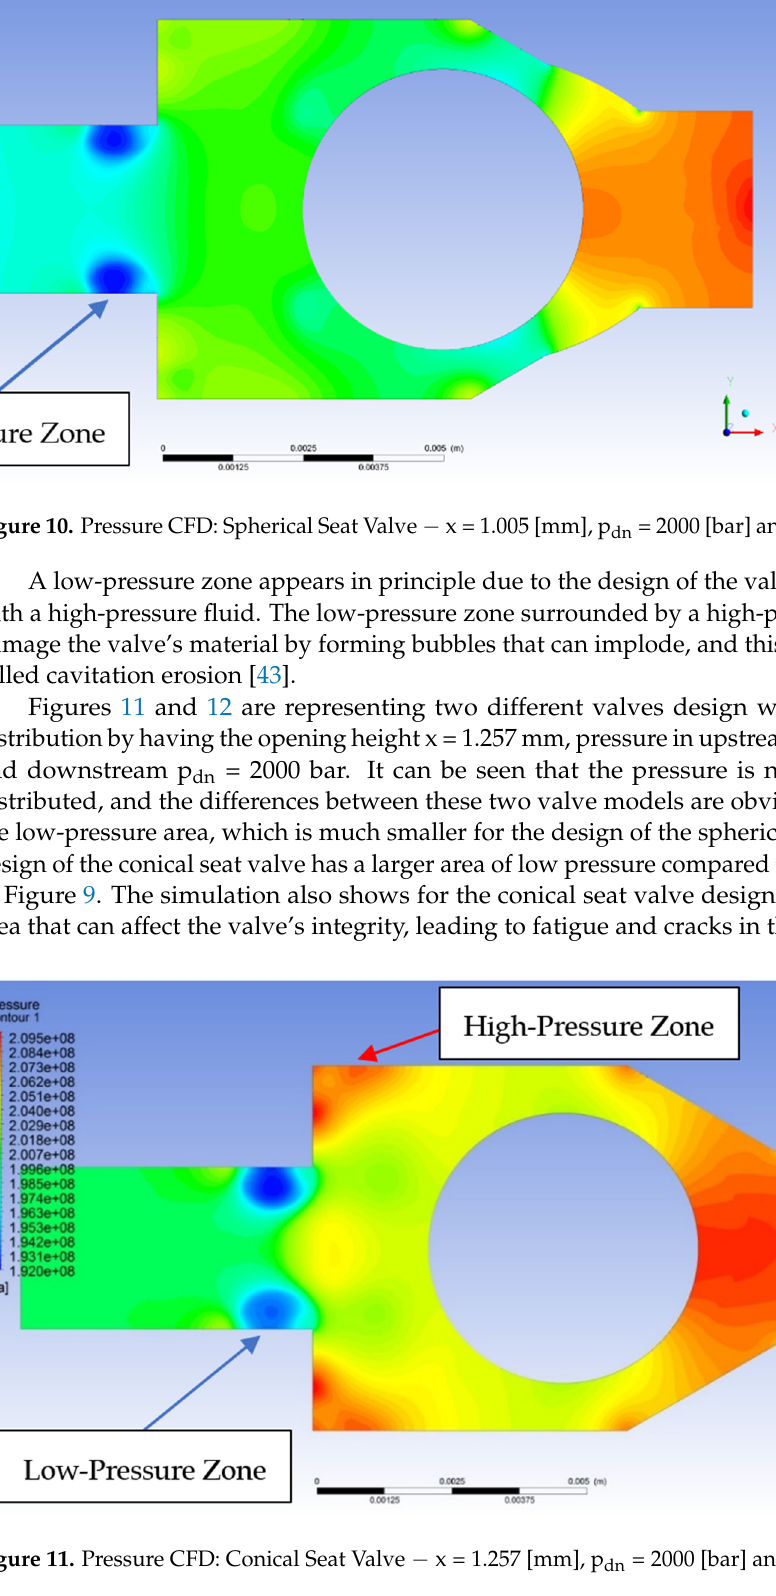
Figure 9. Pressure CFD: Conical Seat Valve − x = 1.005 [mm], pdn = 2000 [bar] and pup = 2100 [bar].